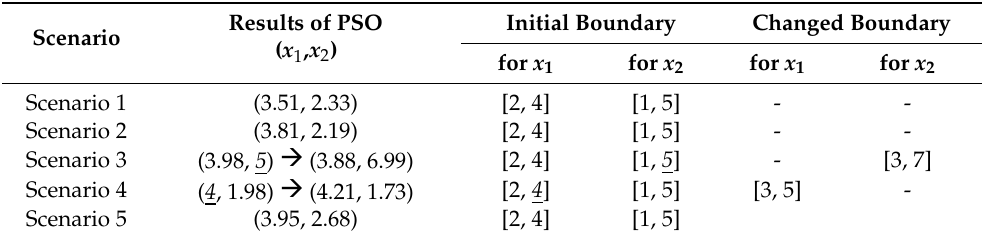
Table 3. Tuning parameters identified by particle swarm